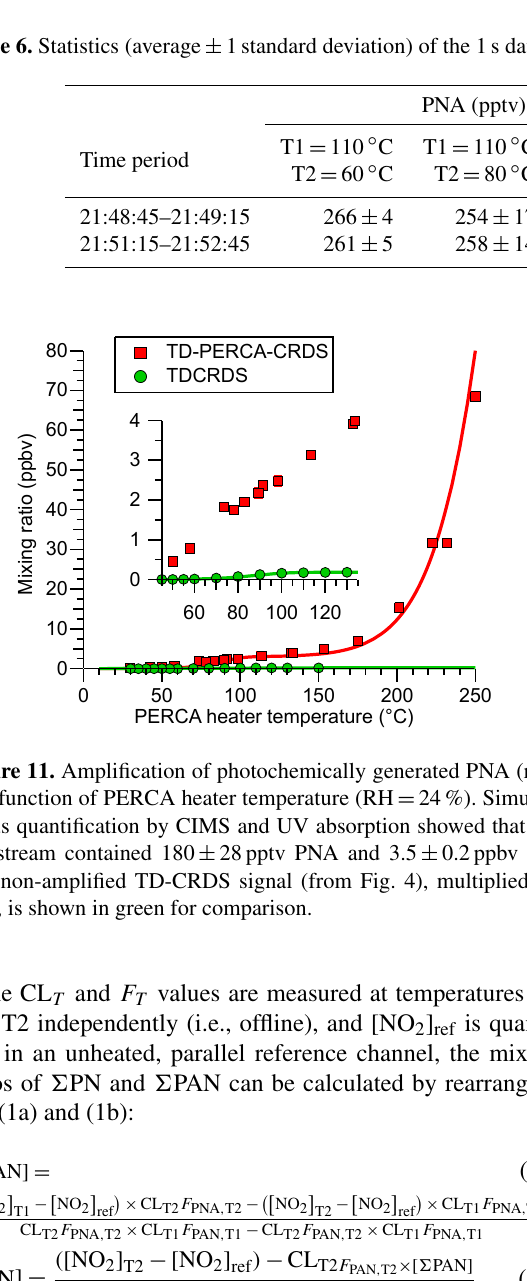
At 21:48:30 and at 21:50:45, PAN was added via the GC pre-column. The product of CL and F for PAN and PNA at 110, 80, and 60 ◦ C was determined offline and summarized in Table 5, assumed to be the same for all (cid:54) PN and (cid:54) PAN species. The time series of PNA and PAN mixing ratios derived from Eq. (2a) and (2b) are presented in Fig. 12b. Consistent results were obtained independent of which pair of channels was used in the calculations (Table